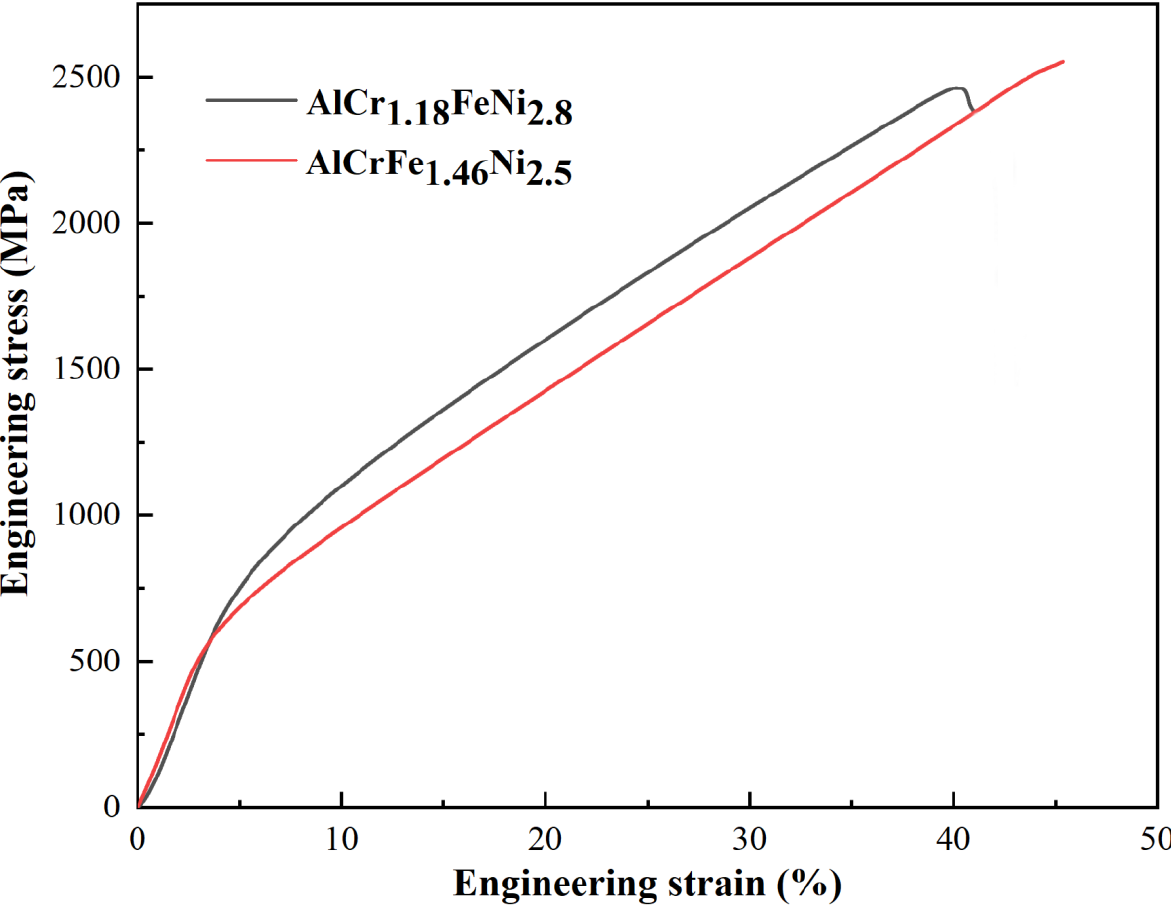
Figure 6. Engineering stress–strain curves of AlCr 1.18 FeNi 2.8 and AlCrFe 1.46 Ni 2.5 alloys at room tem- perature. Table 3. Compressive properties of AlCr 1.18 FeNi 2.8 and AlCrFe 1.46 Ni 2.5 alloys.